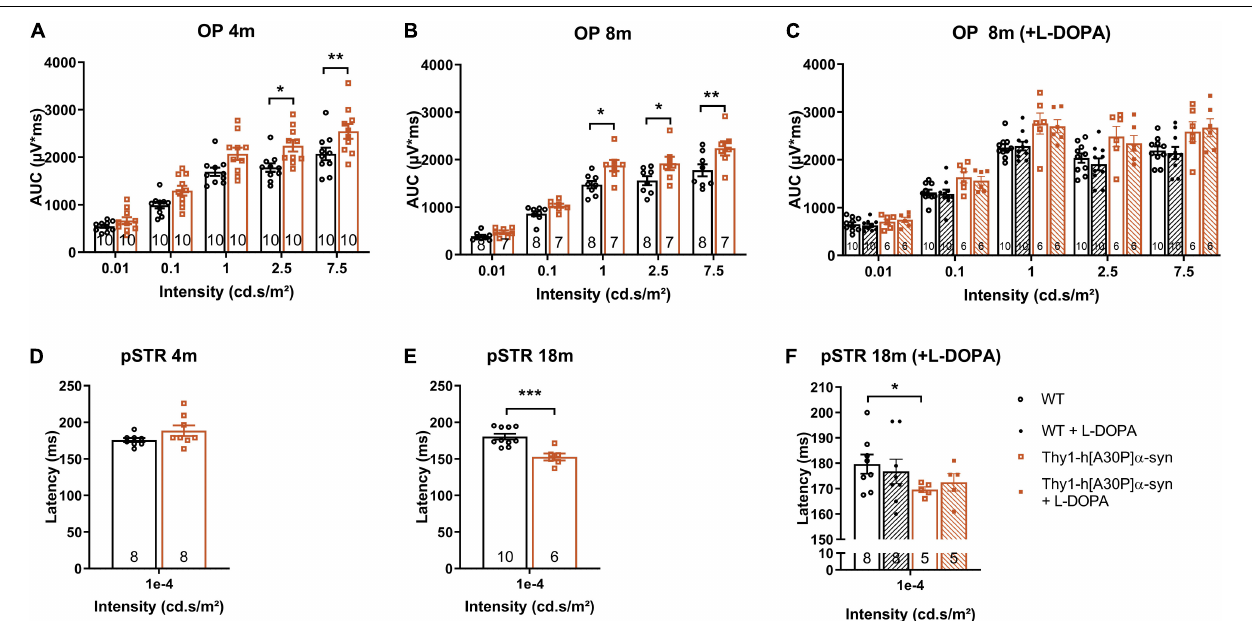
FIGURE 3 | Electrophysiological changes in the retina of older Thy1-h[A30P] α -syn mice cannot be alleviated by L-DOPA treatment. ERG was used to measure the electrophysiological responses of different retinal cell types. (A,B) Quantification of the OPs, measured as the area under the curve (AUC), revealed larger OPs in 4- and 8-month-old α -syn mice as compared to WT controls for light stimuli with high intensity. (D,E) Quantification of pSTR response did not reveal any differences at 4 months of age, yet a shorter pSTR latency time was observed in 18-month-old transgenic mice as compared to WTs. (C,F) L-DOPA treatment did not have an overt rescue effect on observed OP (C) and pSTR (F) differences in α -syn mice. Repeated measures Two-Way ANOVA (A–C) with Bonferroni’s multiple comparisons post hoc test or unpaired t -test (D–F) : * p < 0.05; ** p < 0.01; and *** p < 0.001. Full ERG data is shown in Supplementary Figure 1